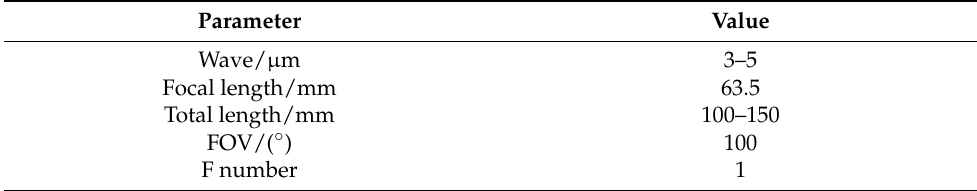
Table 1. Optical design